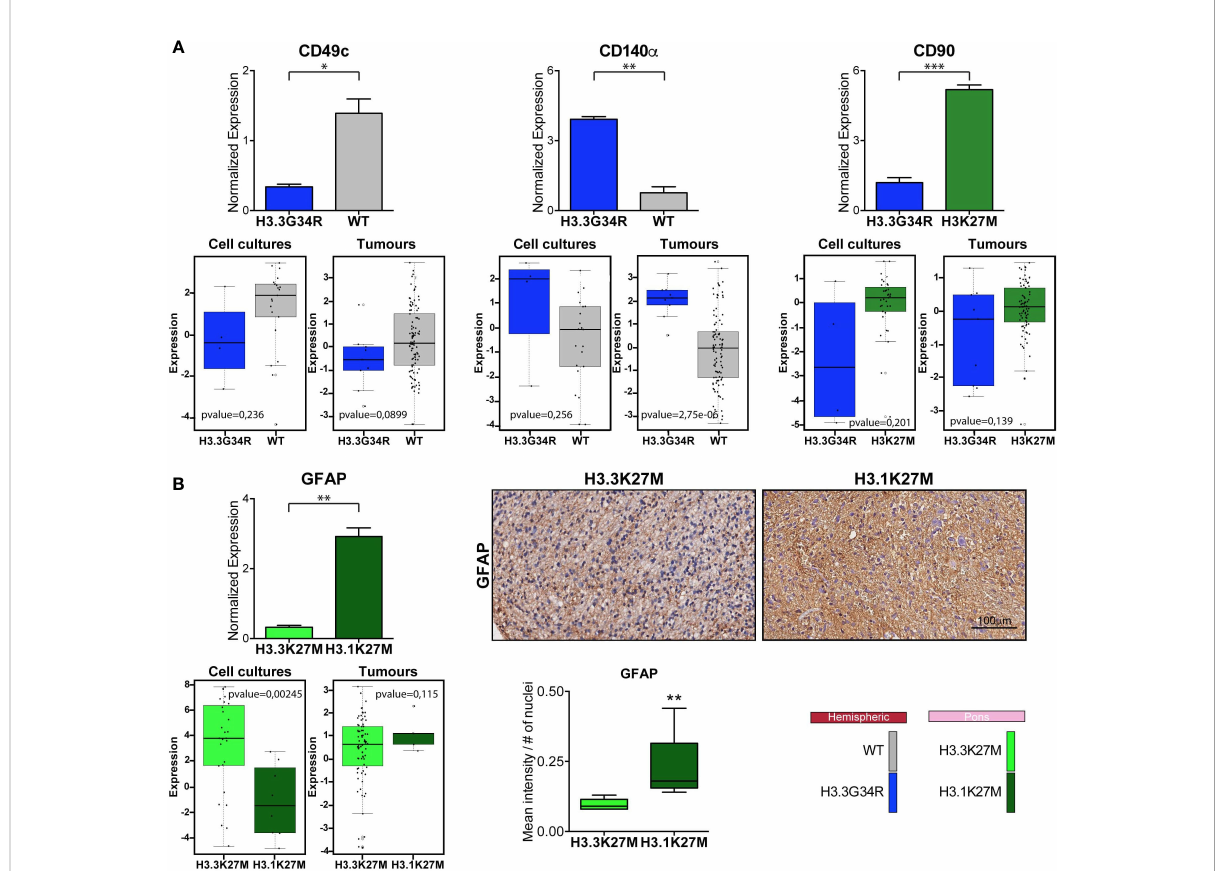
FIGURE 5 Comparison of marker expression in different molecular PDHGG patient-derived cell lines. (A) Bar plots showing the comparison between the H3WT vs H3.3G34R and H3K27M vs H3.3G34R PDHGG molecular subgroups relative to the expression of the indicated marker. The data on the top refer to the marker normalized expression obtained from mass cytometry data analysis while the plots on the bottom were obtained from RNA seq analysis on both patient-derived cell cultures (n=68) and tumor tissues (n=133). Data are represented as mean ± SEM. (B) Bar plots relative to the expression of GFAP marker in the H3.3K27M vs H3.1K27M PDHGG molecular subgroups obtained from CyTOF and RNA seq analysis. Representative images of GFAP immunohistochemistry on H3.3K27M and H3.1K27M PDHGG FFPE tissue slides together with the relative quanti fi cation of GFAP signal intensity normalized on the number of nuclei (n=5 for H3.1K27M; n=6 for H3.3 K27M). * p < 0.05; ** p < 0.01; *** p <